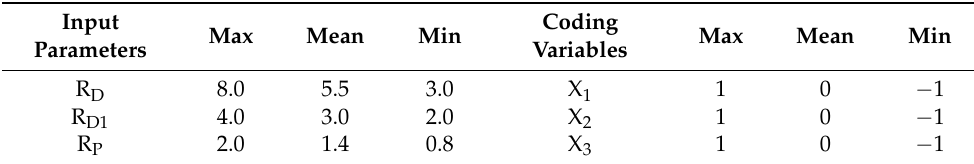
Table 6. Input parameters and coding variables.